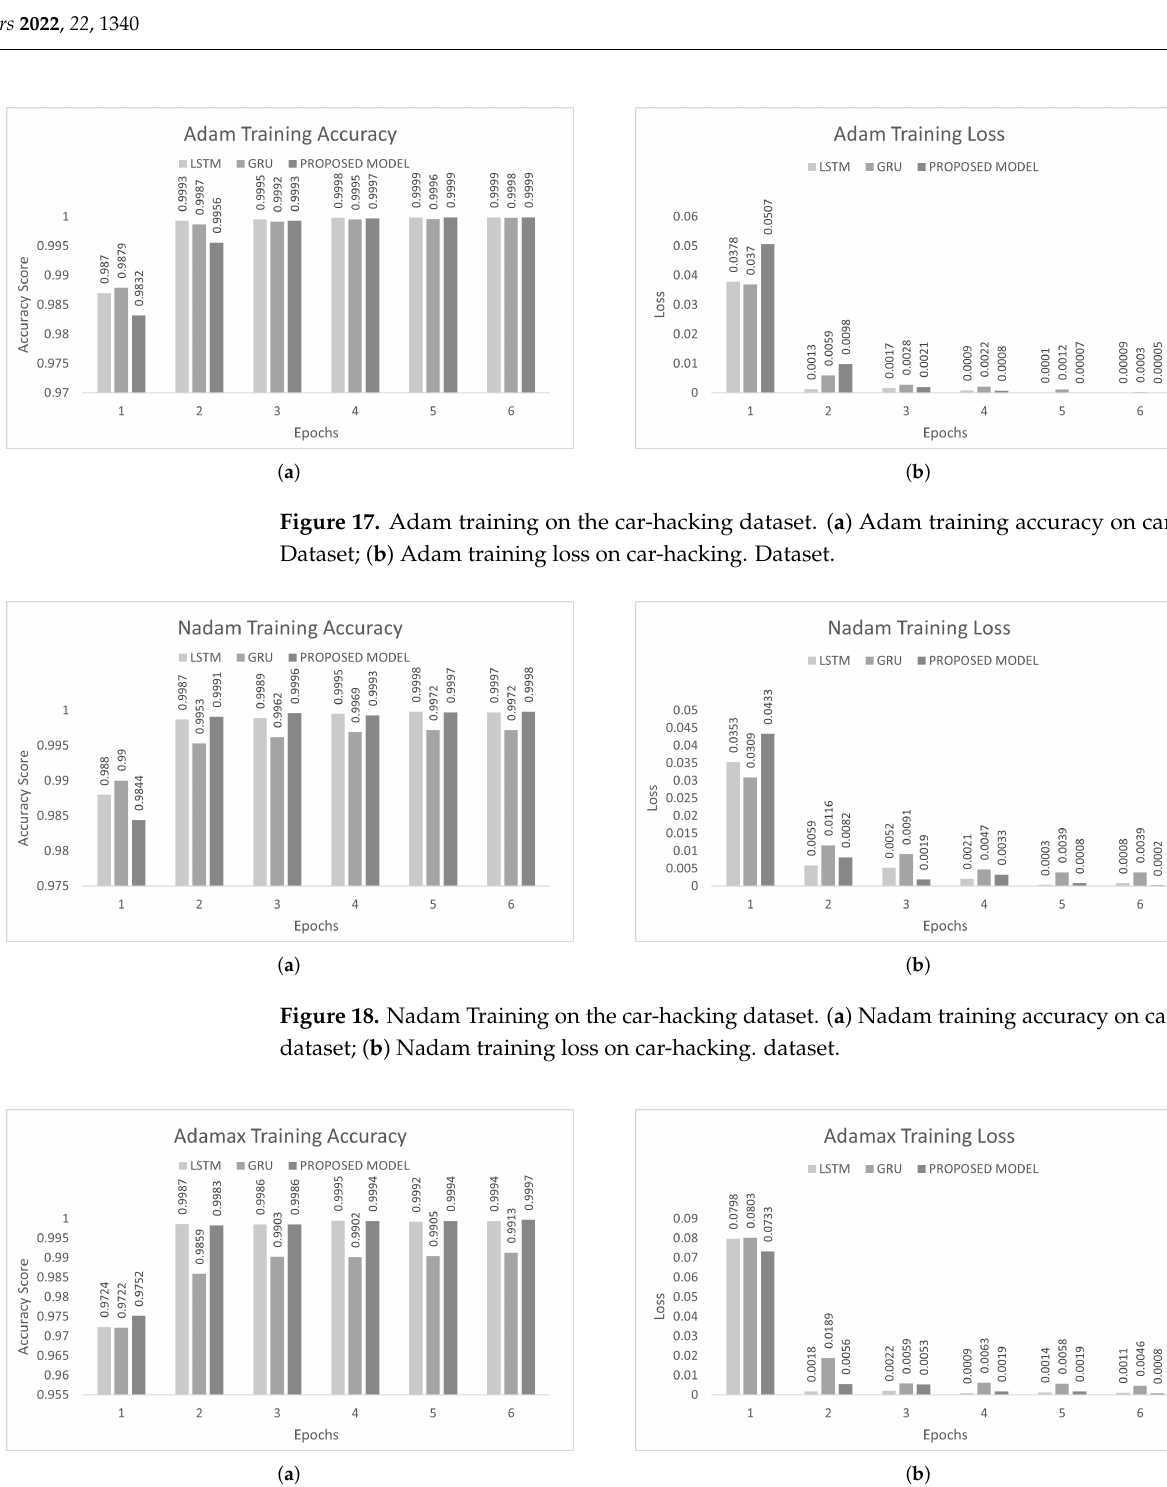
Figure 19. Adamax training on car-hacking dataset. ( a ) Adamax training accuracy on car-hacking. dataset; ( b ) Adamax training loss on car-hacking.